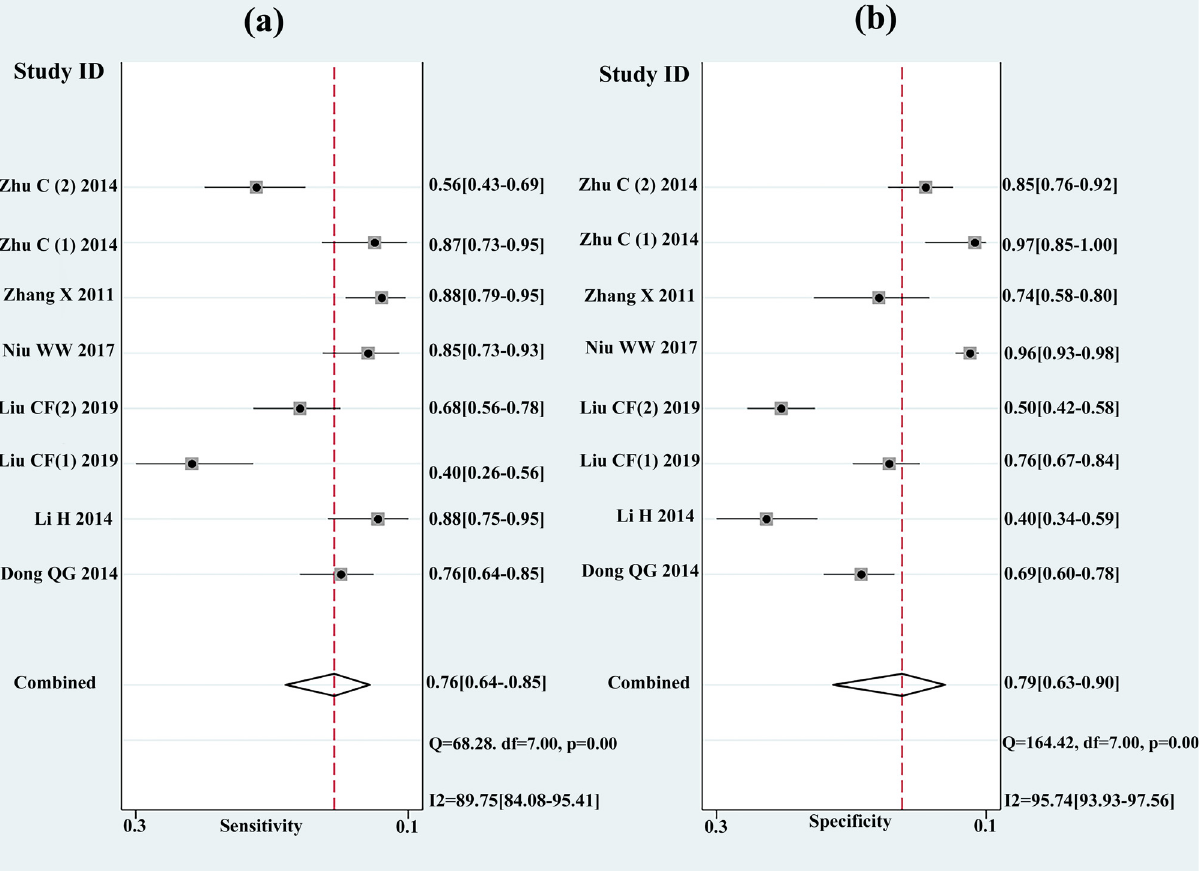
Figure 3: Forest plots of sensitivity ( a ) , speci fi city ( b ) for miR - 92a in the diagnosis of gastric cancer.